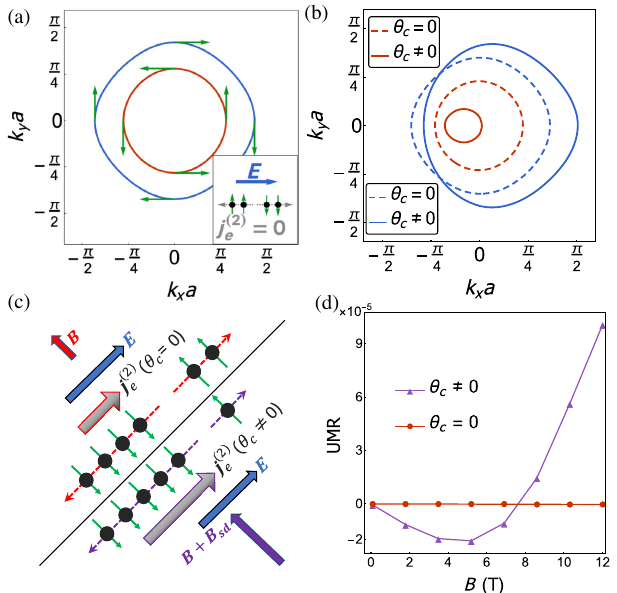
FIG. 4. EnhancementofUMRbyspincanting.(a)Spintextureof the conduction bands in the absence of a magnetic field. Because of spin-momentum locking arising from the Rashba effect, when an electric field is applied, a pure spin current but no nonlinear charge current is produced, as depicted in the inset. (b) Spin-dependent distortion of the bands in the presence of a magnetic field at both zero canting (dashed curves) and finite canting (solid curves). The two bands are shown here in red and blue. (c) Generation of a nonlinear charge current transverse to the applied B field (top left), which increases considerably in the presence of canting (bottom right). (d) Plots of the calculated UMR at finite and vanishing canting as functions of the magnetic field B . In the presence of canting, the UMR is stronger by 2 orders of magnitude.